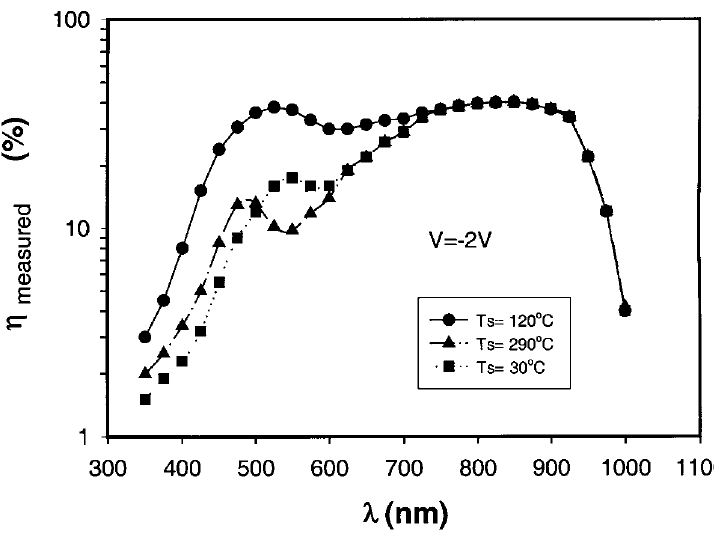
FIGURE 5 Measured quantum efficiency, Z measured , of the Al = a-SiC:H Schottky junction included in the Al = a-SiC:H = c-S(n) = Al structure, as a function of the wavelength, l , for a reverse bias voltage V ¼(cid:3) 2Vand for three (cid:5) ) and T s ¼ 290 (cid:1) C( different substrate temperatures T s ¼ 30 (cid:1) C ( j ), T s ¼ 120 (cid:1) C (